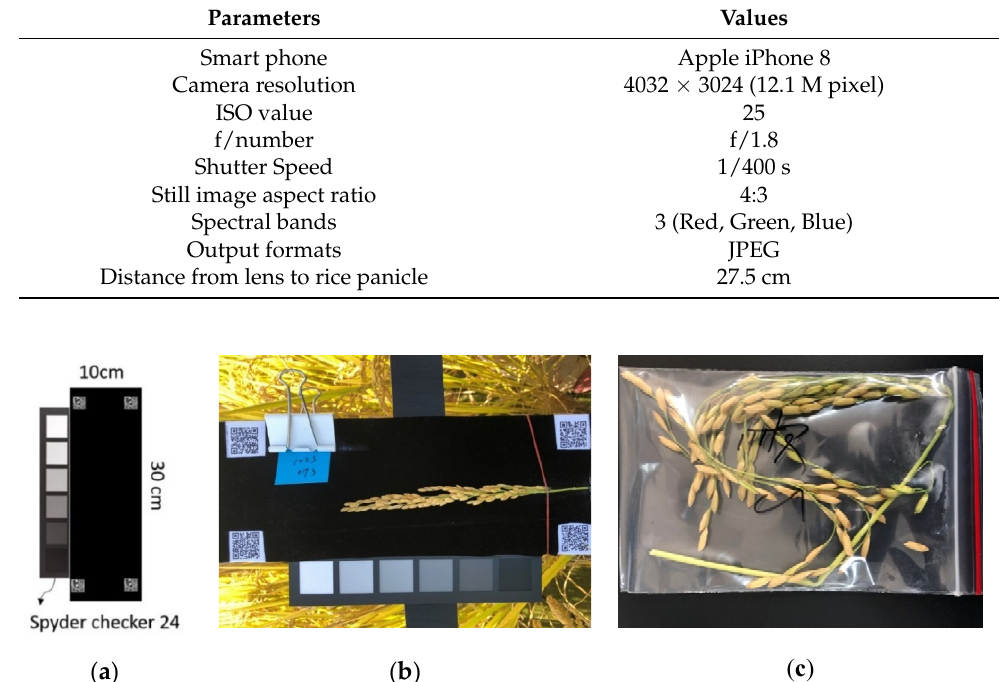
Table 2. Smart phone and camera parameters.